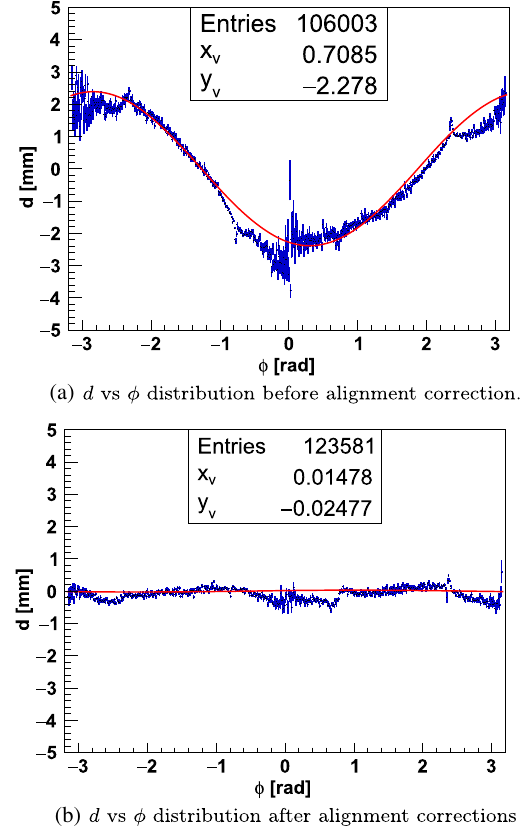
FIG. 9. Estimation of the transverse beam spot position with the BGV detector. Red lines are the result of a fit with Eq. (3) estimating the beam spot position ð x v ; y v Þ